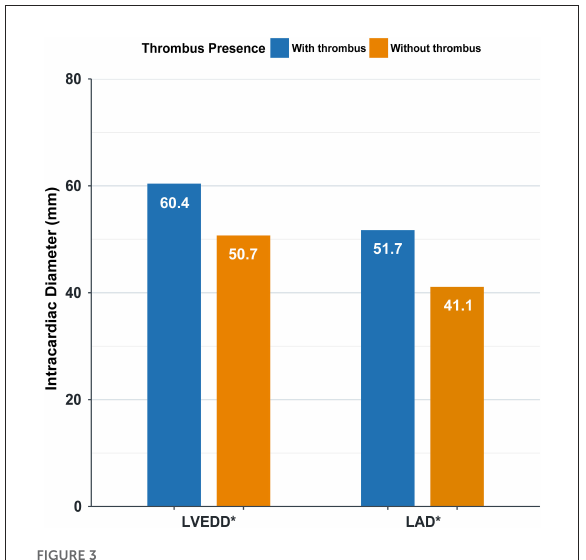
FIGURE3 Intracardiac diameter in patients with and without thrombus. LVEDD, left ventricular end-diastolic diameter; LAD, left atrial diameter; * P < 0.0001.